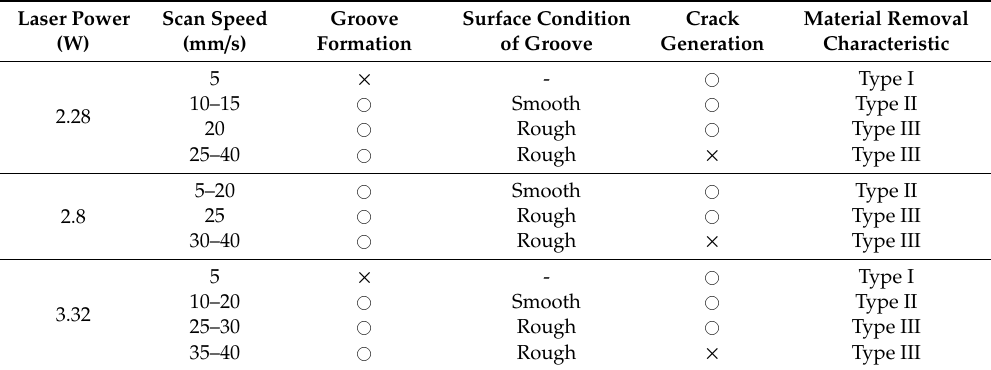
Table 4. Process characteristics depending on the laser scanning condition.